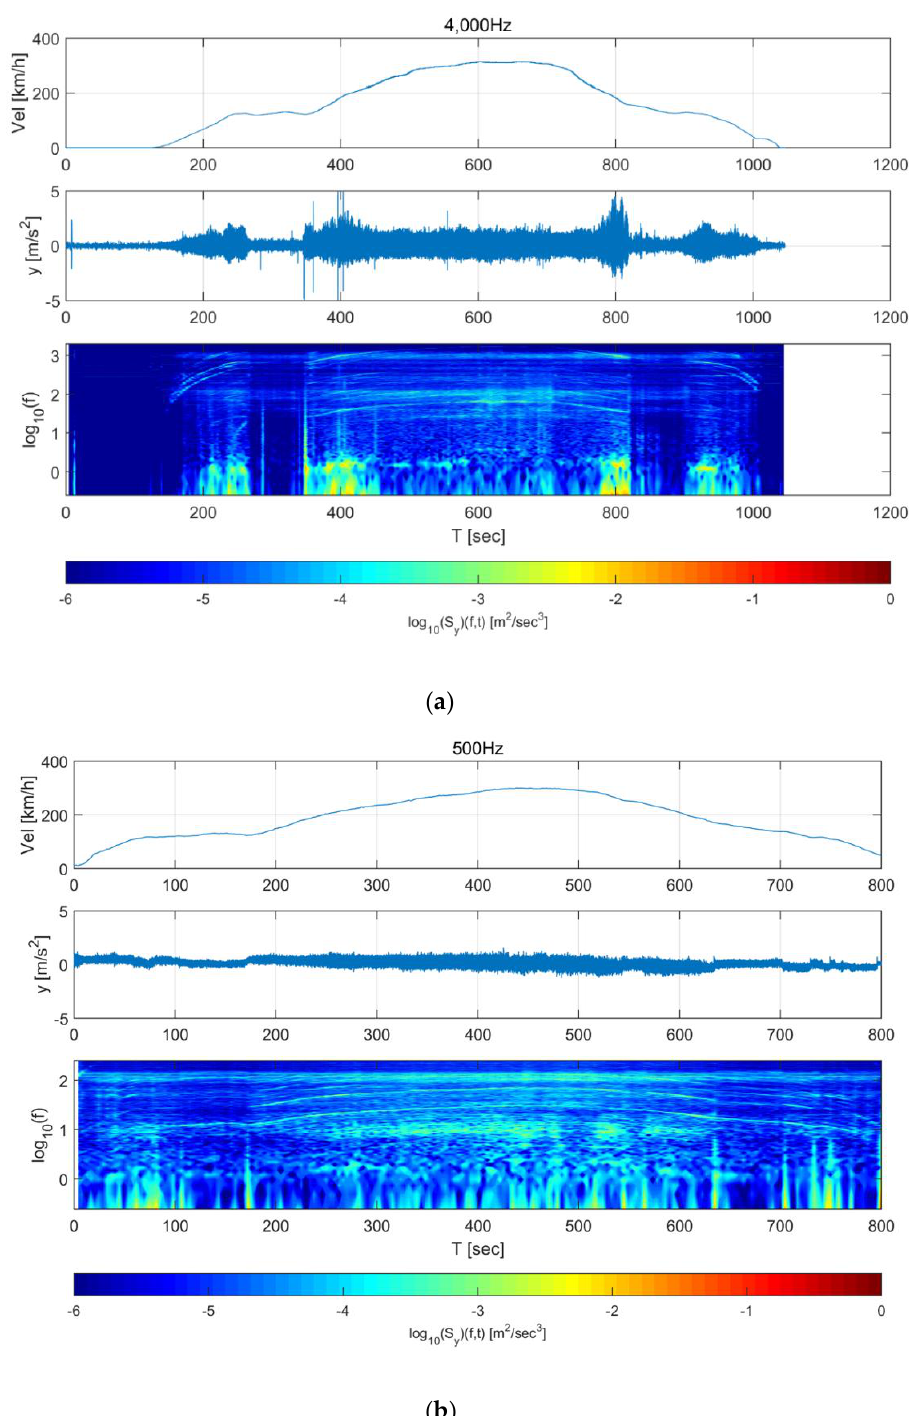
Figure 10. Short-time Fourier transform of Korea Train Express (KTX) data in the transverse direction for ( a ) 4000 Hz and ( b ) 500 Hz data.